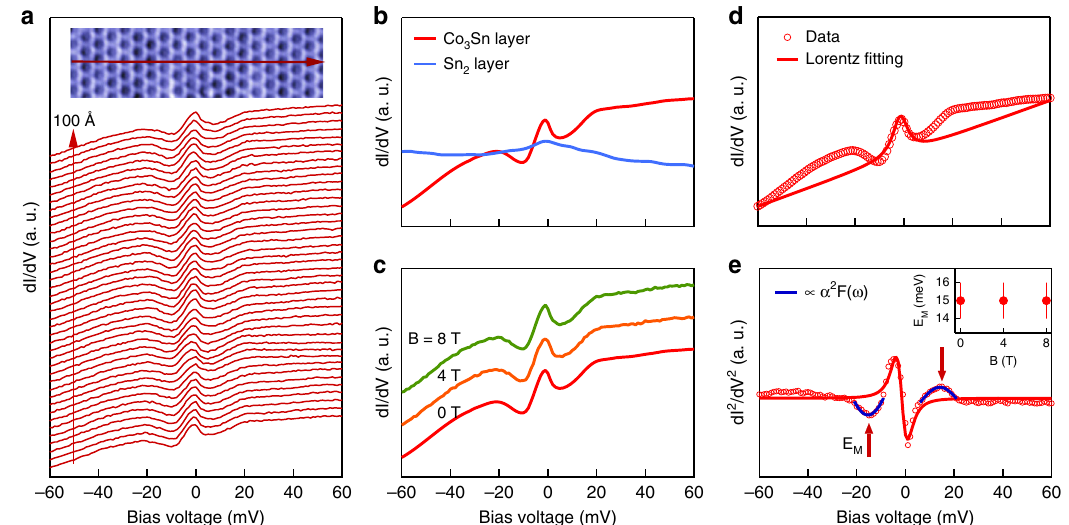
Fig. 2 Bosonic mode coupling from kagome electrons. a Differential conductance spectra taken along the arrow draw on the Co 3 Sn layer shown in the inset. b Spatially averaged d I /d V spectra for Co 3 Sn layer and Sn 2 layer, respectively. c d I /d V spectrum for Co 3 Sn layer taken at different external magnetic fi elds applied along the c axis. d Fitting of the spectral peak in the Co 3 Sn layer with a Lorentzian. e Second differential conductance for the data in d with the extra Gaussian-like peaks marked by blue lines centered at the energy E M = ±15 meV marked by red arrows. The inset plot shows the E M value is independent of the external magnetic fi